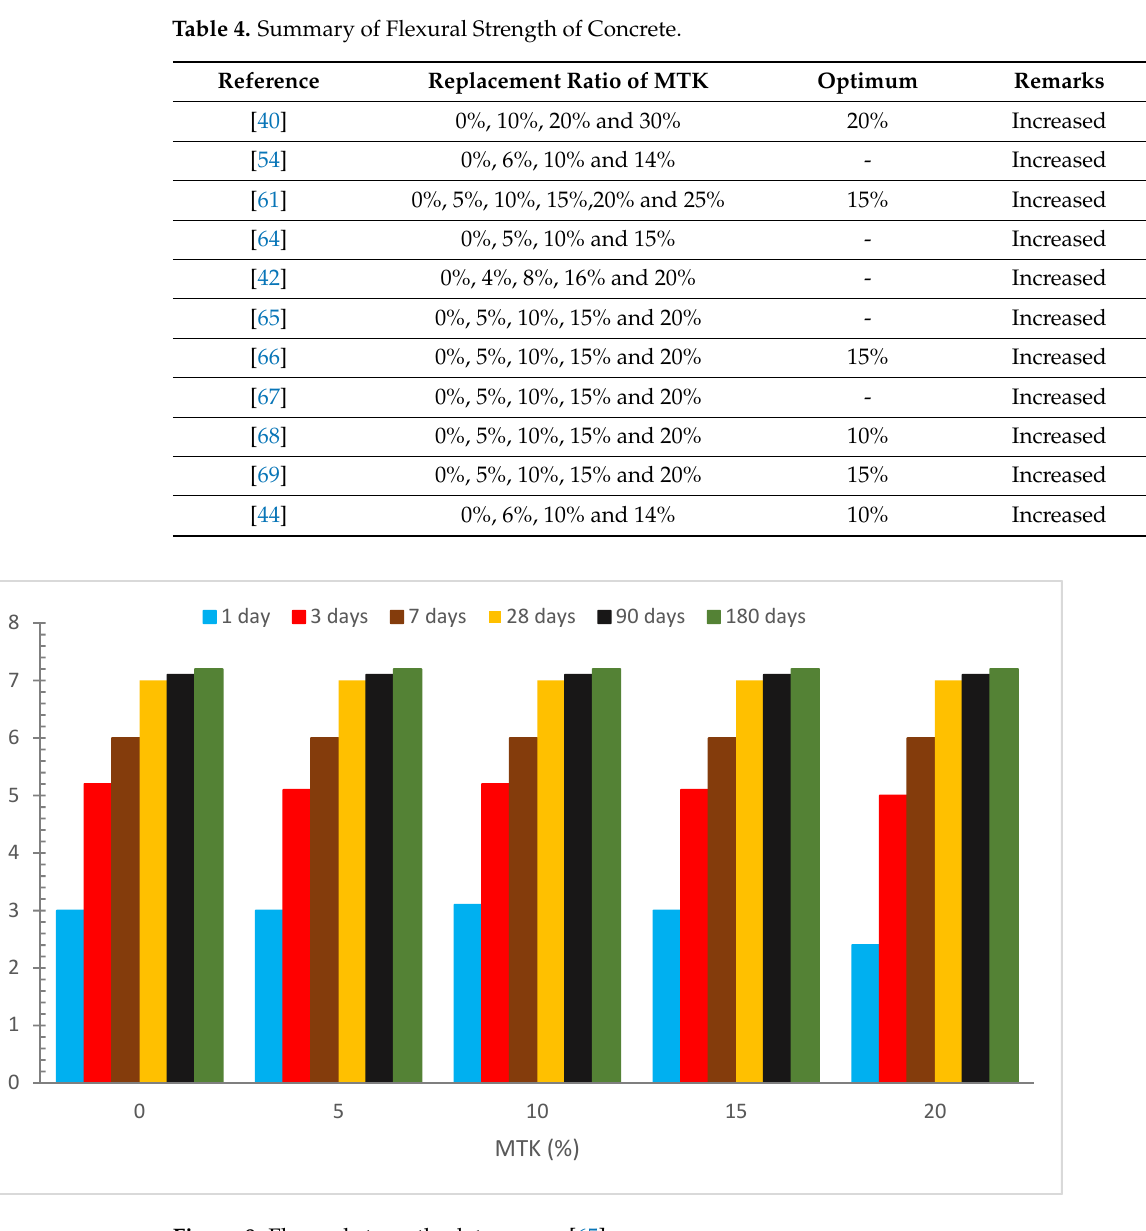
Figure 8. Flexural strength: data source [65]. Table 4. Summary of Flexural Strength of Concrete.